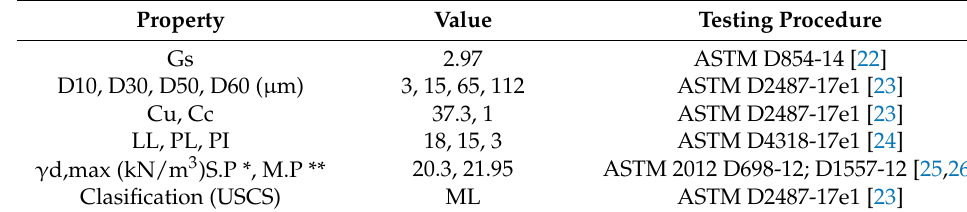
Table 2. Physical characteristics of filtered tailing.